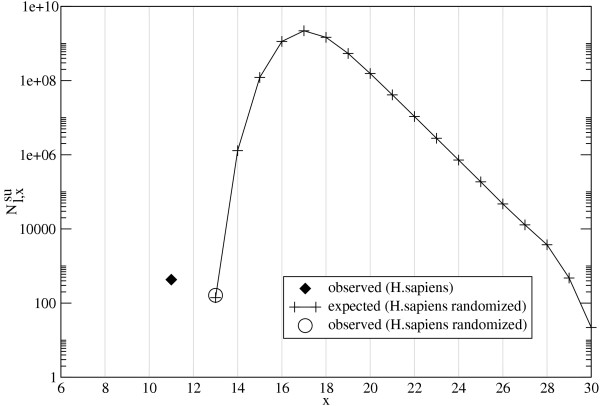
Expected number of shustrings in the randomized human genome. Expected number, , of local shortest unique substrings of length x. Parameters used in equation (1) are l = 2.84·109 and 2p = 0.409 and correspond to the euchromatic part of the human genome.